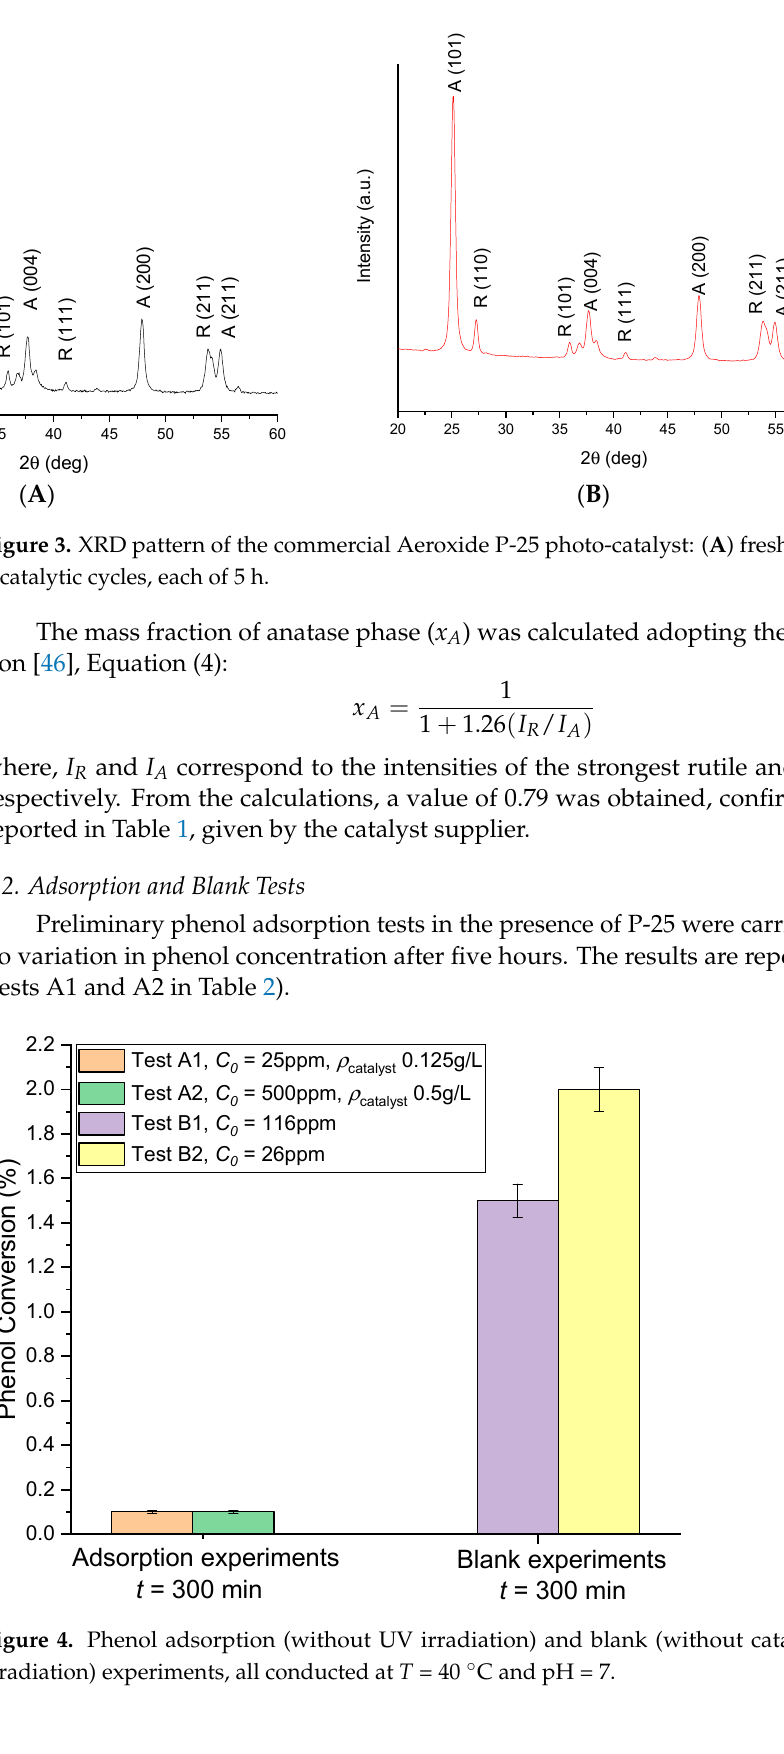
( B ) Figure 5. E ff ect of the initial phenol concentration on: ( A ) the phenol conversion; ( B ) the observed reaction rate ( r obs ), fi xing T = 40 °C and a catalyst loading of 0.50 g/L. These results are consistent with literature [36,48,49], in which it is reported that the phenol photodegradation reaction rate does not show a linear trend with the initial sub- strate concentration. It is reported in the literature that by increasing the phenol concen- tration, hydroxyl radical generation is inhibited by phenol occupation of the active sites of the catalyst; moreover, phenol adsorbs photons, so increasing its concentration results